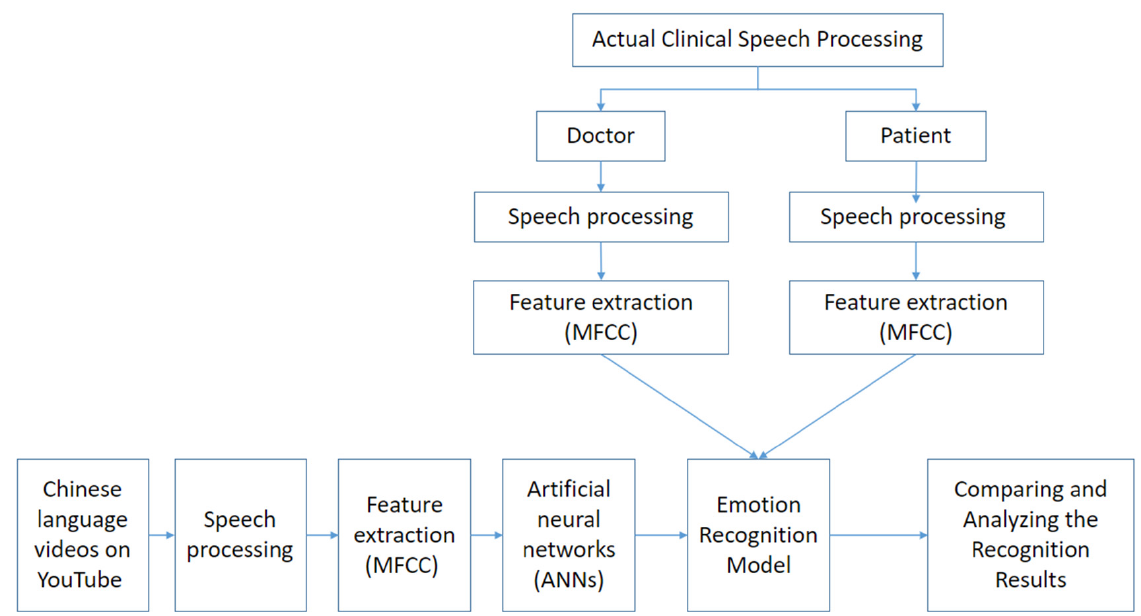
Figure 3. Research framework.